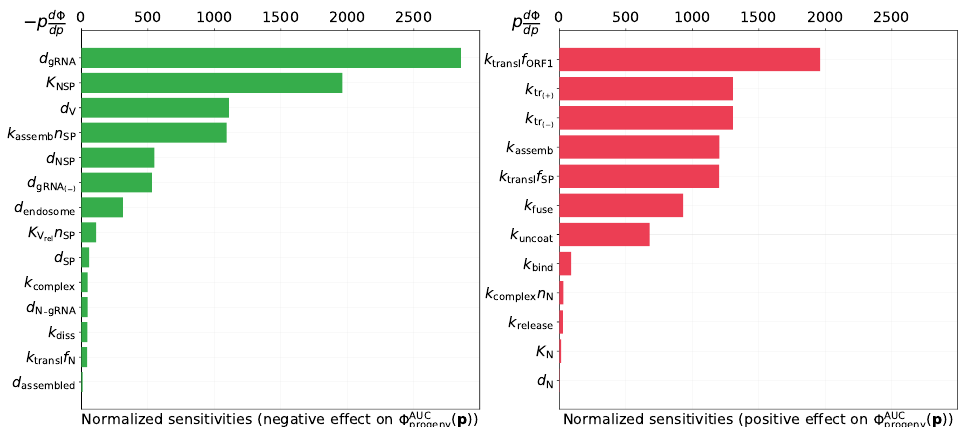
Figure 7. Local normalized sensitivity indices having negative ( left ) and positive ( right ) effect on the area under the curve for released virions Φ AUC progeny ( p )